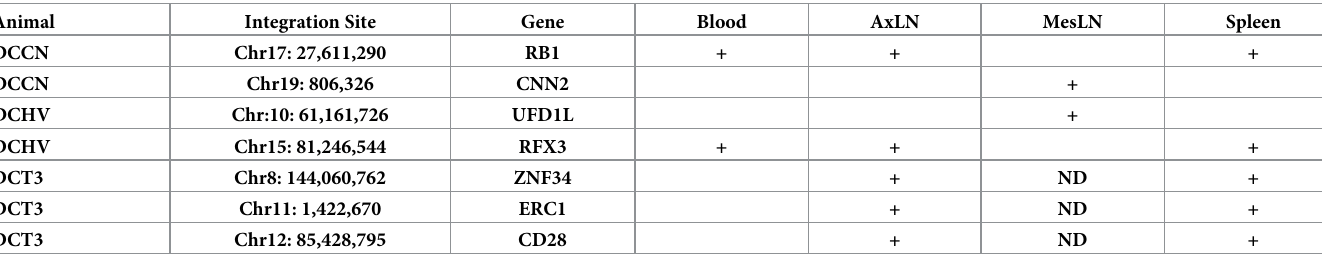
BACH2 and MKL2 , which are not preferential targets for HIV integration, STAT5B is a pre- ferred target for HIV integration, which complicates the analysis. We found 5 SIV proviruses integrated in STAT5B in samples taken from infected animals before ART was initiated, and 4 additional proviruses in samples taken after a year of ART treatment. In the on-ART samples we analyzed, there were too few integration sites in STAT5B to determine if there was a selec- tion for integration sites in STAT5B on-ART. We did find one expanded clone in which an SIV provirus was integrated in the first intron of the STAT5B gene, in the same orientation as the gene, which is the region of the gene and the orientation of the provirus that is associated with clonal growth of HIV infected T cells in humans. We did a similar comparison of the fractions of integration sites in the pre-ART PBMC dataset and the on-ART dataset for all of the genes to look for evidence of selection for provi- ruses integrated into any other genes in the macaques on ART. Because the current on-ART dataset of SIV integration sites is relatively small, there were only a few integration sites for most of the genes, and we were not able to find evidence of selection for integration sites in any gene that was statistically significant. The largest SIV infected clone (judged by the number of times the integration site was recovered) had an SIV provirus inserted in the RB1 (retino- blastoma) gene in the opposite orientation relative to the gene. RB1 is a frequent target for SIV integration ex vivo . 43 SIV proviruses were found in the RB1 gene in the rhesus PBMC infected in vitro. We identified only one clone in which there was an SIV provirus integrated in RB1 in any of the on-ART samples and there were 3 proviruses found in RB1 in the pre-therapy sam- ples. Thus, the data we have do not provide any evidence that SIV integration into the RB1 gene is connected to the clonal expansion and persistence of the infected cells.